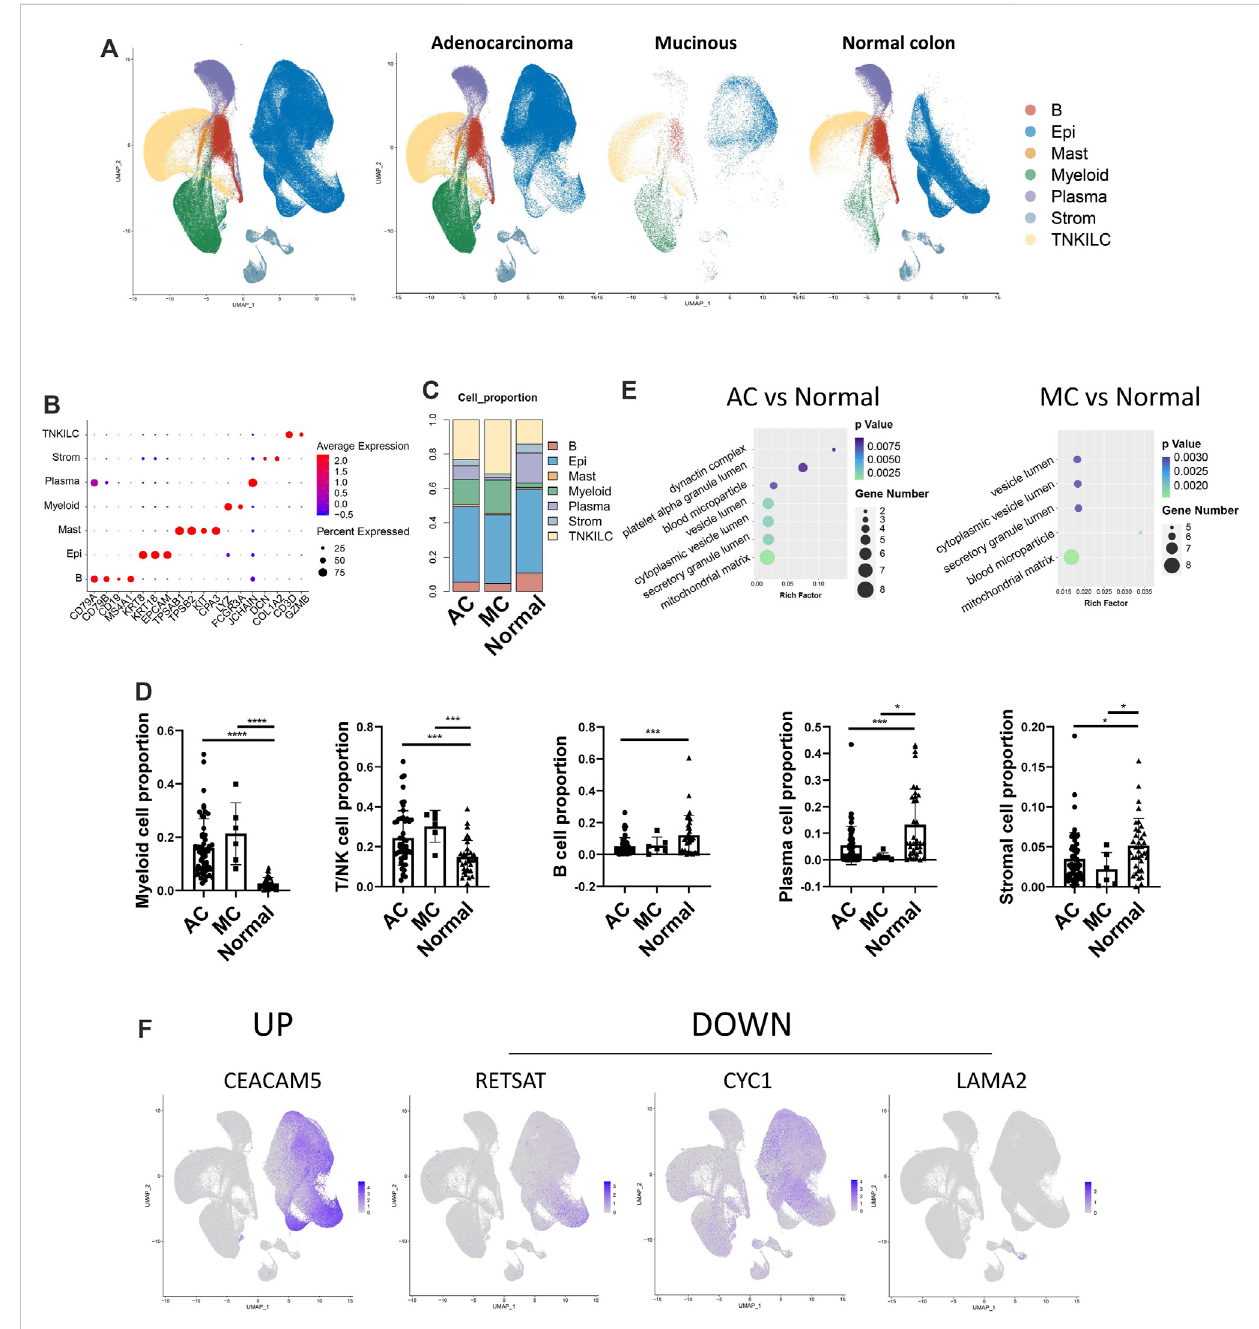
Single-cell transcriptome atlas of human colorectal adenocarcinoma not otherwise speci fi ed, mucinous adenocarcinoma, and normal colon. (A) Coarse cell annotation of scRNA-seq data of two types of colorectal adenocarcinomas and normal colon. (B) Marker genes of coarse cell type of scRNA-seq data on two types of colorectal adenocarcinomas and normal colon. (C) Coarse cell type proportion of two types of colorectal adenocarcinomas and normal colon. (D) Bar plot showing the signi fi cance of different cell-type proportions in two types of colorectal adenocarcinomas and normal colon. (E) BP pathways which were enriched in DEGs from AC and normal tissue, and MC and normal tissue. (F) Feature plot of mRNA in scRNA-seq data corresponding to differentially expressed proteins found in proteomics